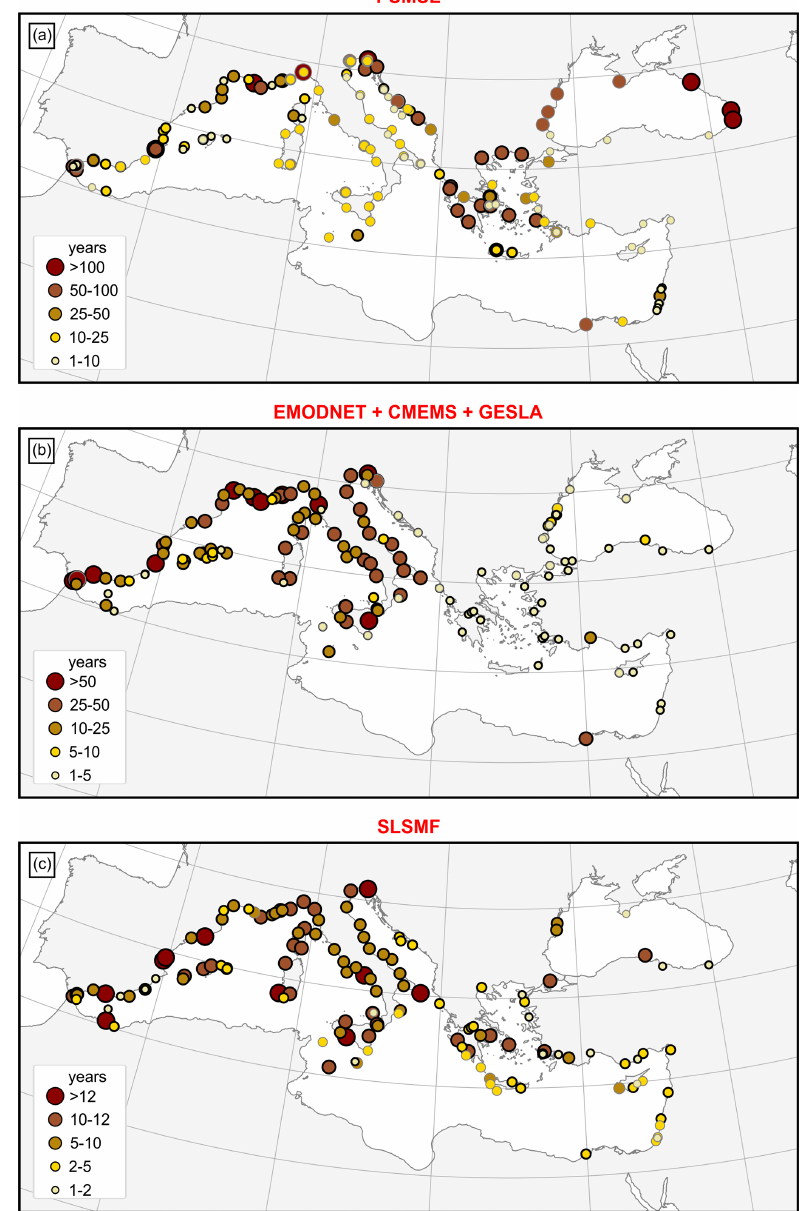
Figure 8. The Mediterranean and Black Sea data accessible as (a) monthly sea level averages in the PSMSL (the length of series is indicated by the size and colour of the circle; thick border lines denote the series that end in 2018 or later and grey the series that end earlier), (b) hourly sea level data in EMODnet Physics, the Copernicus Marine Service, or GESLA (the length of series is indicated by the size and colour of the circle; thick and grey lines denote the series that do or do not, contain the data in 2021, respectively), and (c) 1min series in the IOC-SLSMF (the length of the operability period is indicated by the size and the colour of the circle; thick and grey border lines denote the stations that were or were not operational on 15 November 2021,